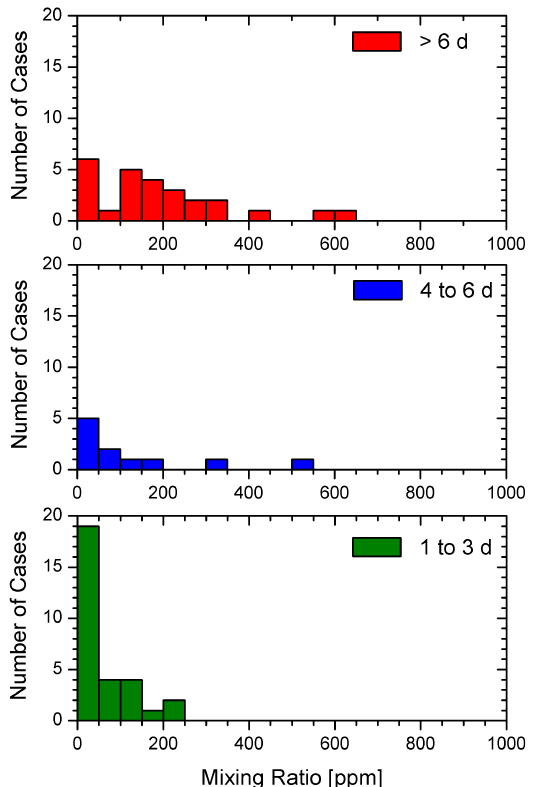
Fig. 16. Histograms of the minimum H 2 O volume mixing ratios on days with DIAL observation of Figure 16. Histograms of the minimum H 2 O volume mixing ratios a stratospheric air intrusion for three different ranges of air-mass travel times; only days with on days with DIAL observation of a stratospheric air intrusion for intrusion layers showing humidity minima at 4.5 km and less have been included. three different ranges of air mass travel times; only days with intru- sion layers showing humidity minima at 4.5km and less have been included.